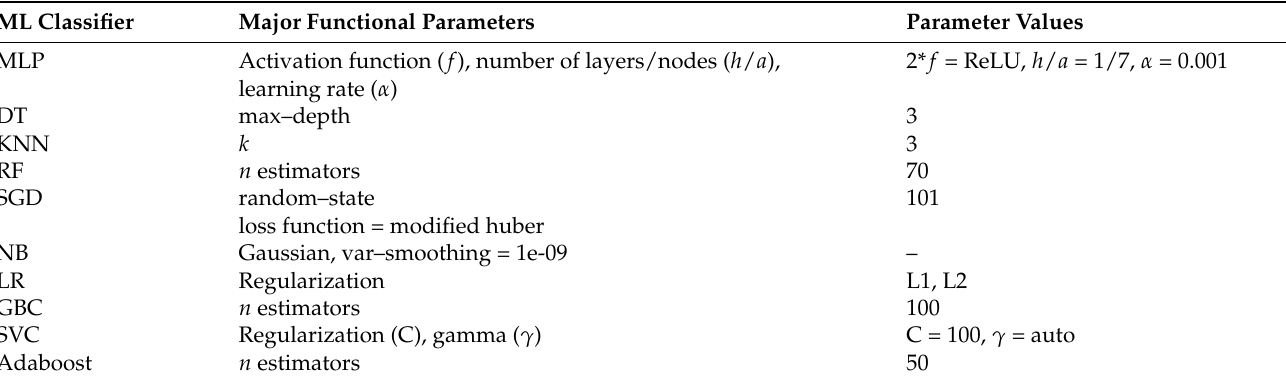
Table 4. Machine Learning Classifiers and their